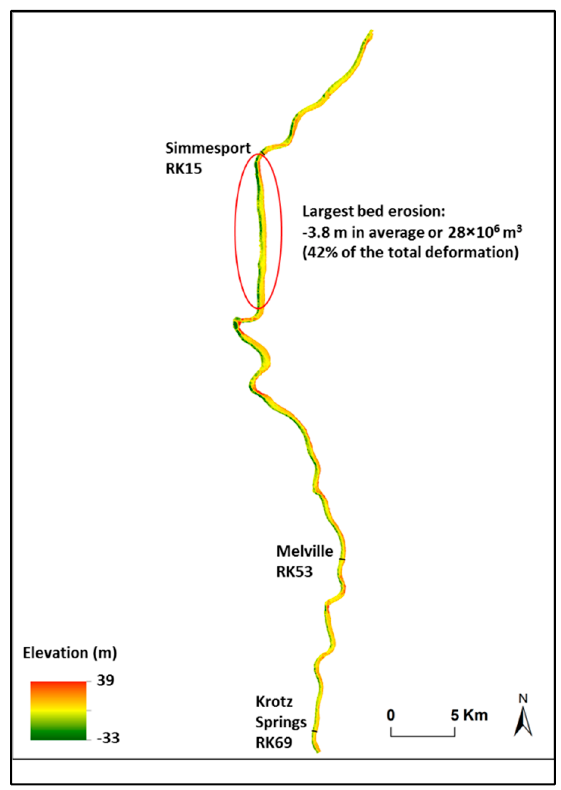
Figure 6. Changes in average bed elevation during 1998–2006 in the uppermost Atchafalaya River. The channel is a 69-km reach downstream of the Outflow Channel (OC) outlet of the Mississippi-Atchafalaya River diversion (RK 0). The x -axis is the river kilometers from the confluence on the Red River and the Outflow Channel.